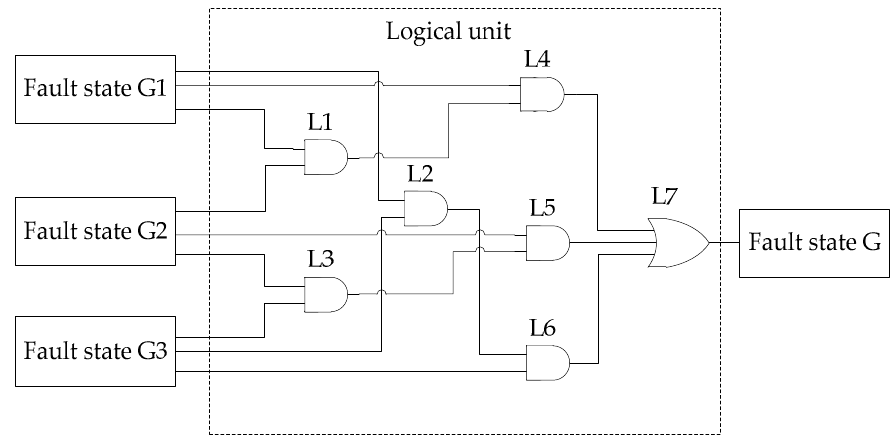
Figure 15. The structure diagram of the logical unit.